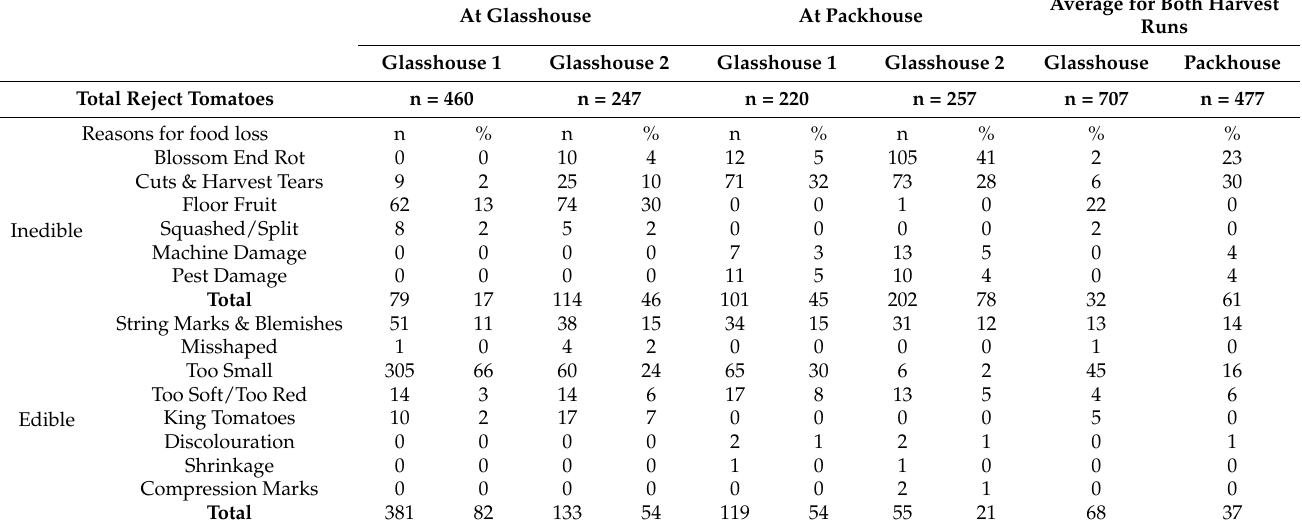
Table 2. Breakdown of the reasons tomatoes became food loss at the glasshouse and packhouse for the audited harvest